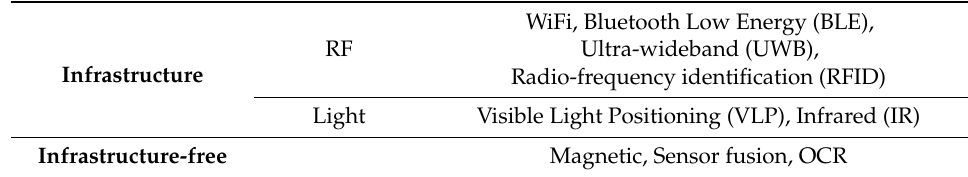
Table 1. Taxonomy of the existing indoor localization